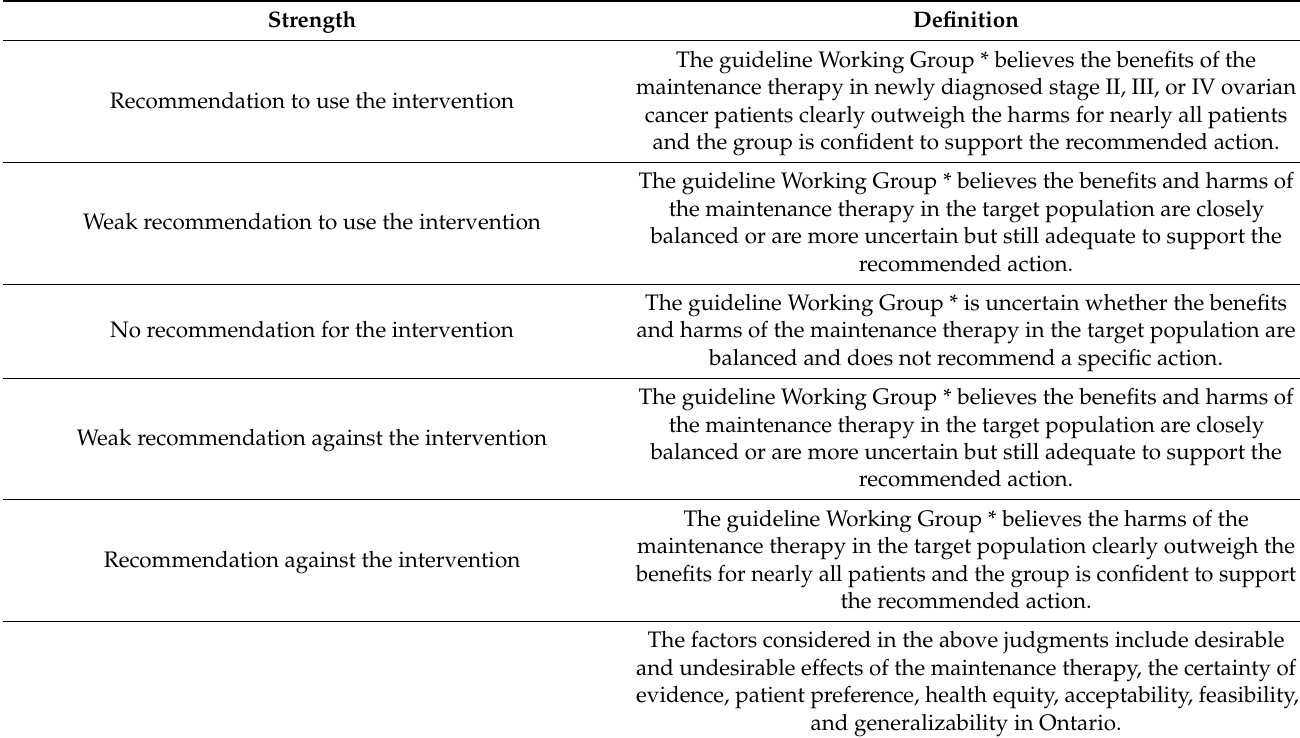
Table 1. Strength of Recommendations for this Guideline (modified based on GRADE